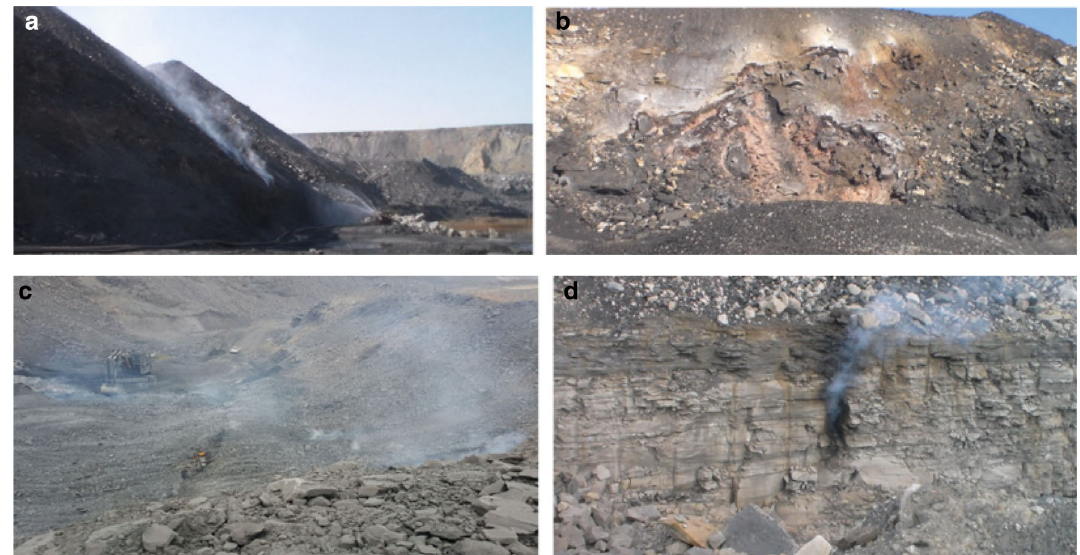
Fig. 2 a Self-heating of run-of-mine and b spoil heaps c signs of self-heating in coal seams and d self-heating of in-seam, Witbank